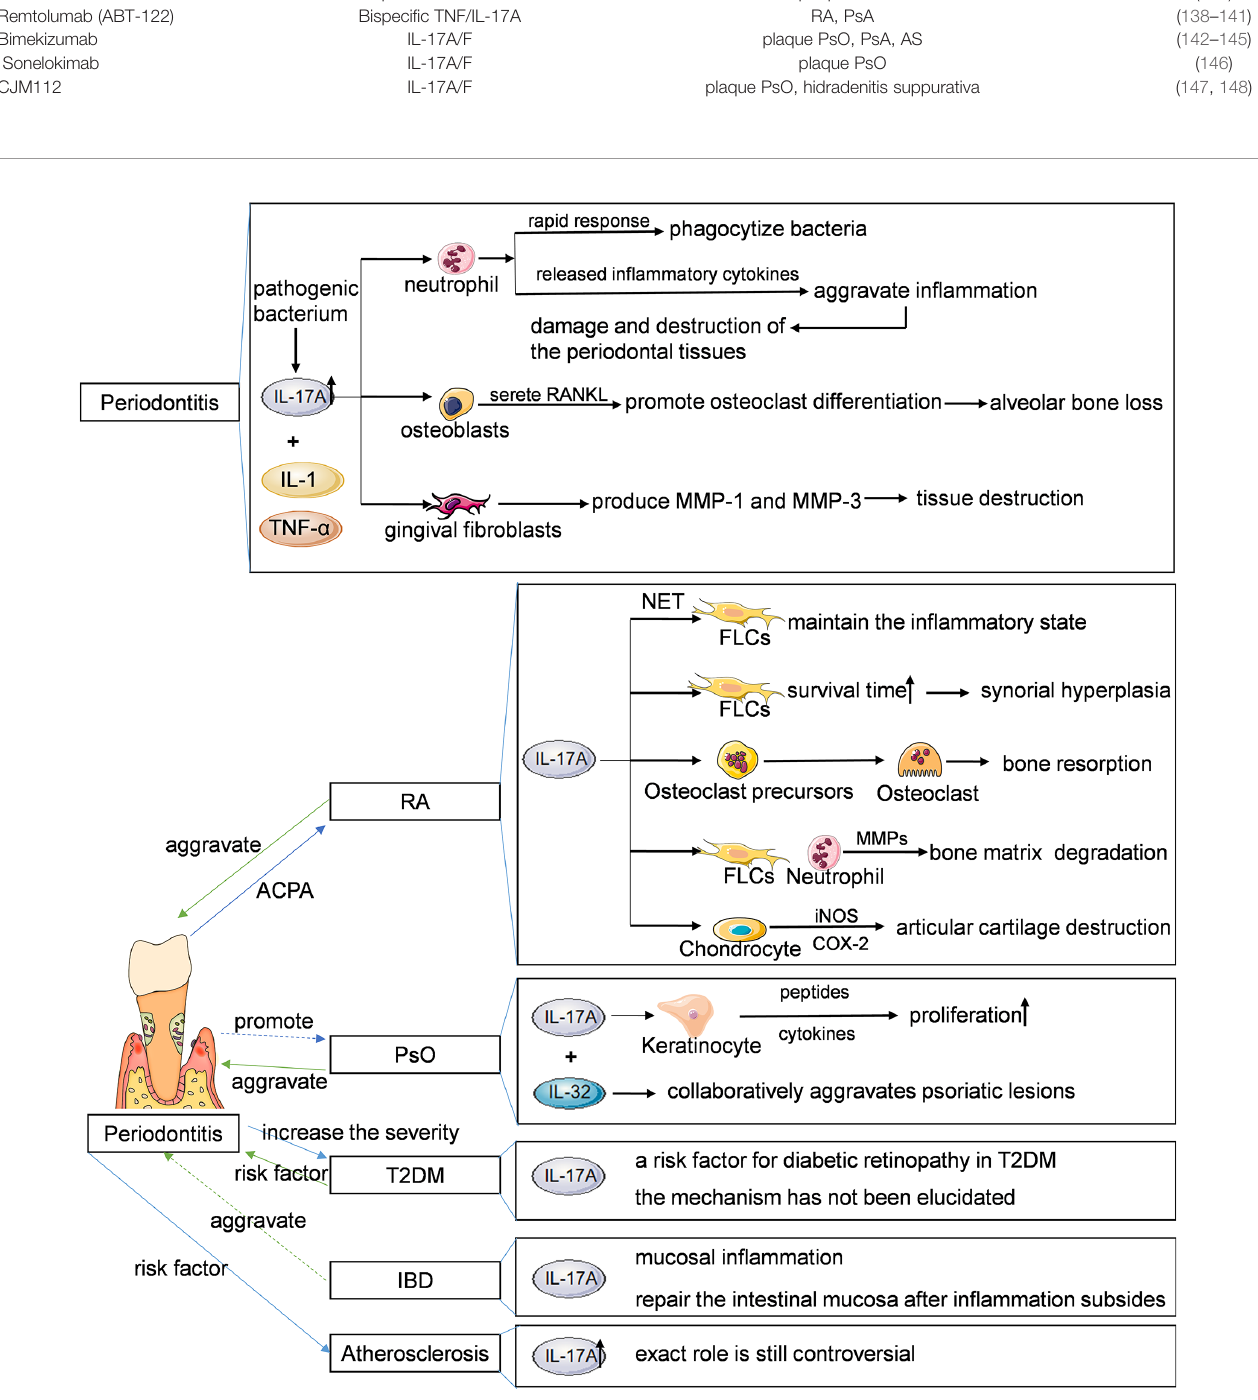
FIGURE 5 | Main features of the IL-17-periodontitis-systemic chronic in fl ammatory diseases. IL, interleukin; RANKL, receptor activator of nuclear factor kappa B ligand; MMP, matrix metalloproteinase; NET, neutrophil extracellular trap; FLSs, fi broblast like synoviocytes; TNF- a , tumor necrosis factor- a ; iNOS, inducible nitric oxide synthase; COX, cyclooxygenase; RA, rheumatoid arthritis; PSO, psoriasis; T2DM, type 2 diabetes mellitus; IBD, in fl ammatory bowel